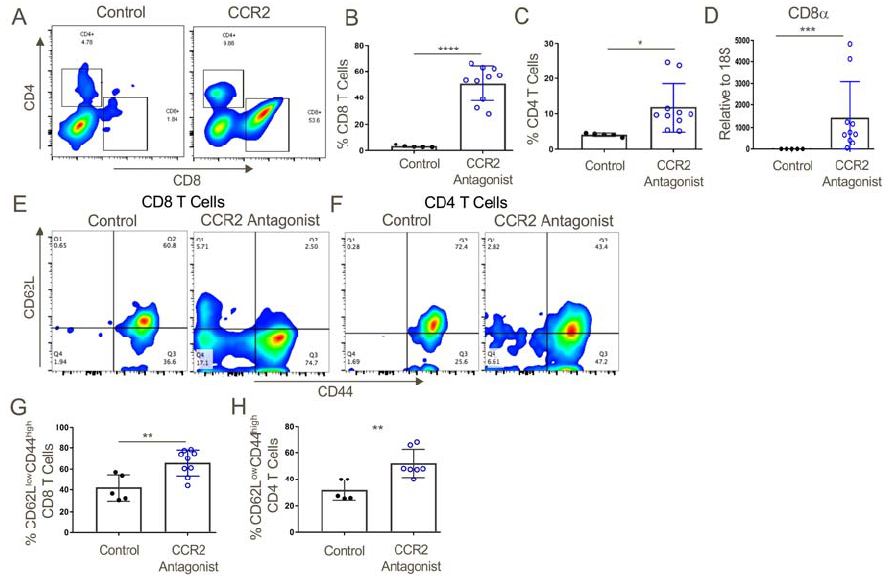
Figure 10. CCR2 antagonist treatment resulted in greater intratumoral infiltration of activated T cells as compared to vehicle control ‐ treated mice. ( A , B ) Tumors from CCR2 antagonist ‐ treated mice exhibited significantly increased infiltration of CD8+ and ( A , C ) CD4+ T cells, and also contained increased transcript levels of ( D ) CD8 α as compared to vehicle control ‐ treated tumors. Additionally, both ( E , G ) CD8+ and CD4+ ( E , H ) T cells from CCR2 antagonist ‐ treated mice displayed a more activated phenotype (increased CD44 and decreased CD62L) compared to T cells from the control group; n = 5–9/group, * p < 0.05, ** p < 0.01, *** p < 0.005, and **** p < 0.001. Data are representative of three independent experiments.